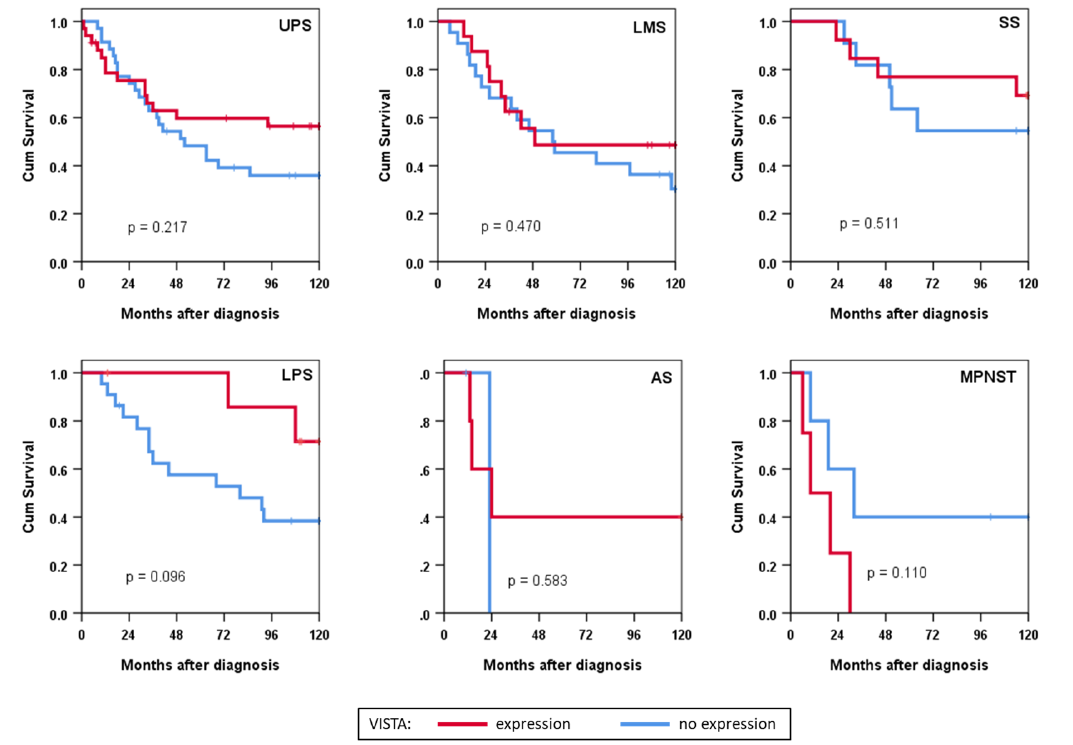
Figure 3. Survival analysis in histotype subgroups depicted as Kaplan–Meier curves stratified according to VISTA expression. UPS: undifferentiated pleomorphic sarcoma; LMS: leiomyosarcoma; SS: synovial sarcoma; LPS: liposarcoma; AS: angiosarcoma; MPNST: malignant peripheral nerve sheath tumour; Cum: cumulative.